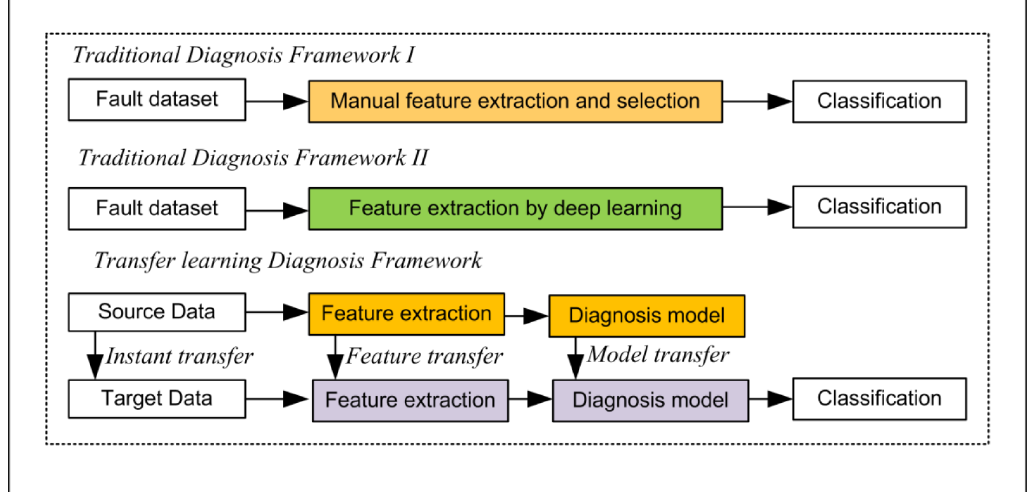
Figure 7. Diagnosis frameworks: The traditional framework (top) and the feature learning frameworks (middle, bottom) (Xiao et al.,